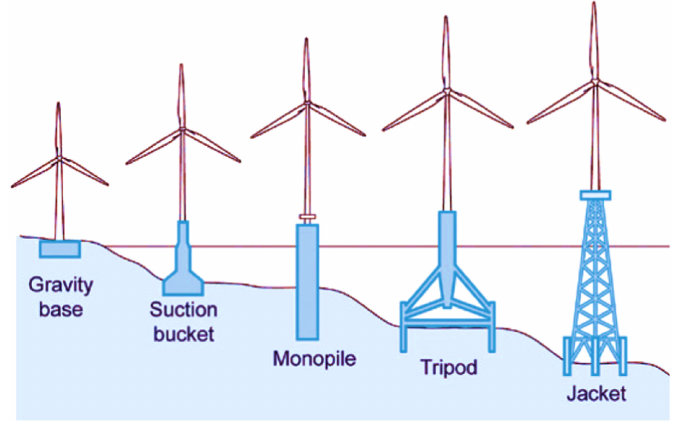
Figure 1. Fixed bottom wind turbine foundations